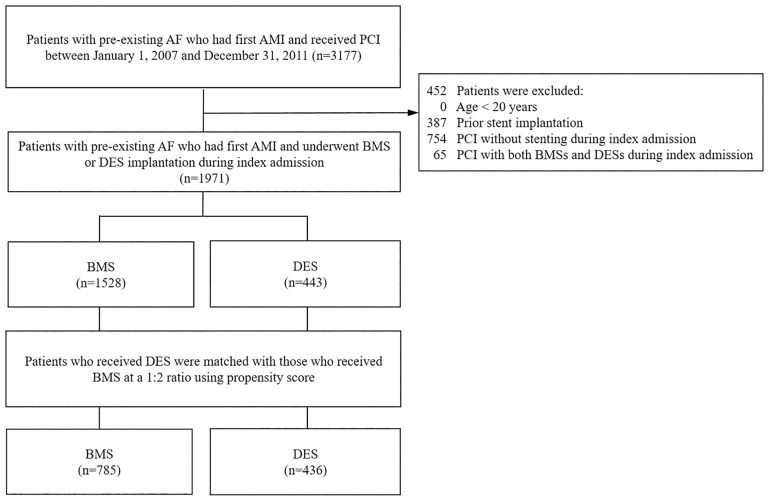
Flow chart for study patient inclusion.AF, atrial fibrillation; AMI, acute myocardial infarction; BMS, bare-metal stent; DES, drug-eluting stent; PCI, percutaneous coronary intervention.